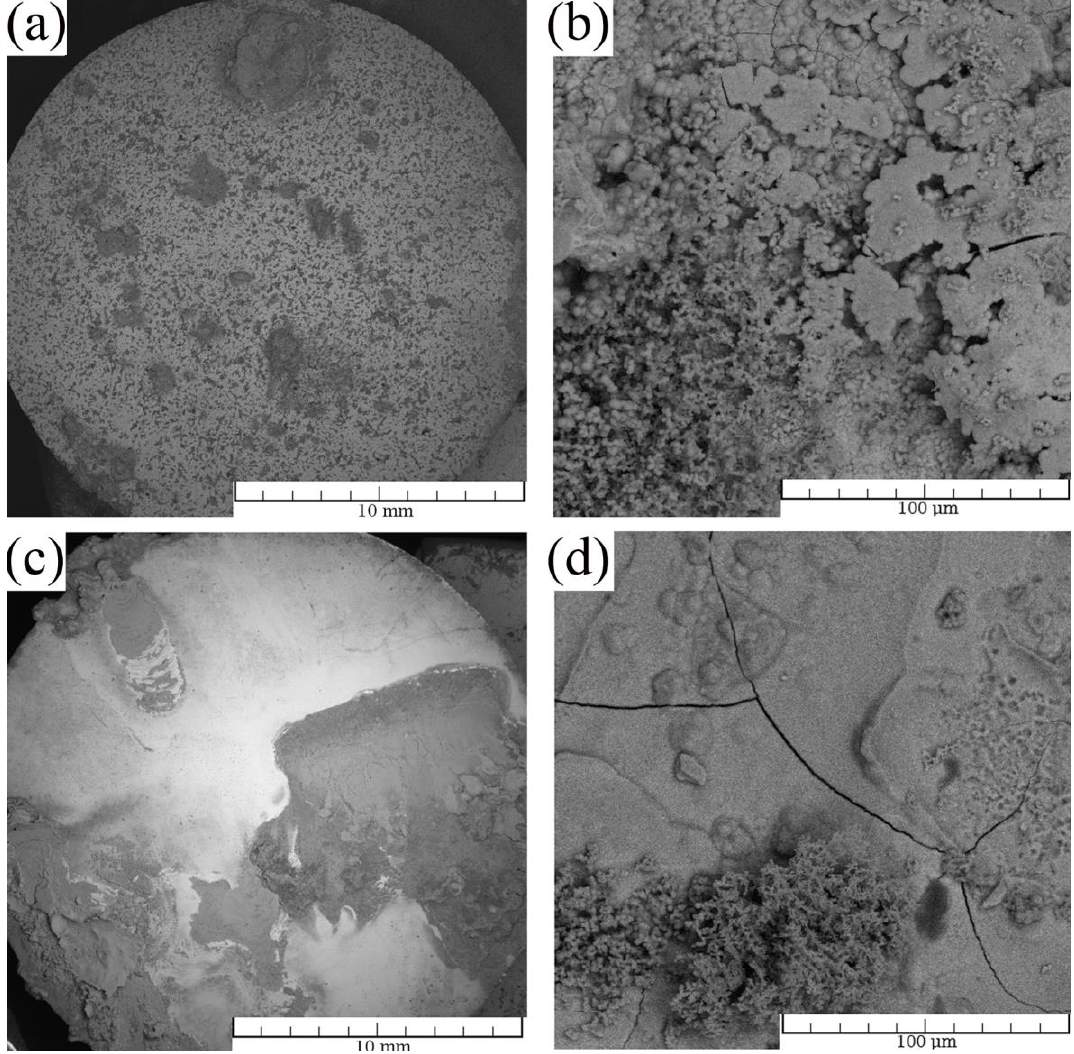
Figure 11. Corrosion products on the surface of corroded ( a ), ( b ) Zn/HA and ( c ), ( d ) Zn.